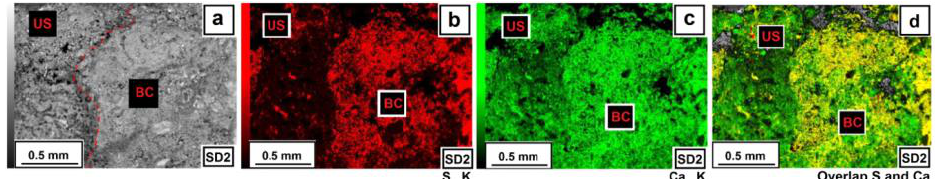
Figure 5. False color maps by SEM-EDS related to SD2 sample as representative. ( a ) EDS analyzed window of the SD2 sample, consisting of the crust (BC) and stone substrate (US); ( b ) distribution of S (red); ( c ) distribution of Ca (green); ( d ) overlapping and distribution map of S and Ca.